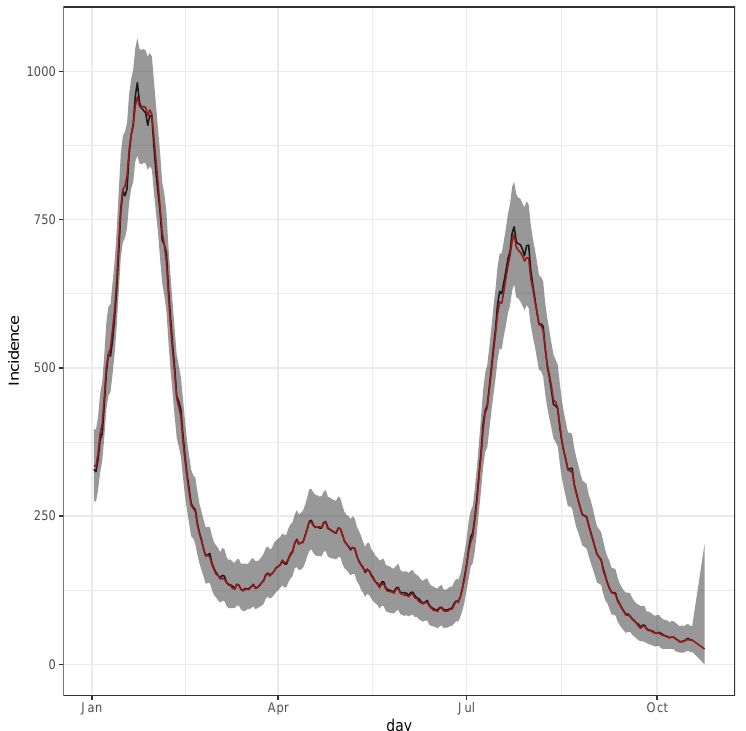
Figure 5. Daily incidence for the year 2021 for overall Spain. Posterior predicted distribution summarized by the median (red) and 99% credible intervals (shaded grey area) for observed days (black) This is the estimation of (1) for observed and future predictions starting from d = 1 day ahead up to d = 7 days ahead, namely from 12 October till 18